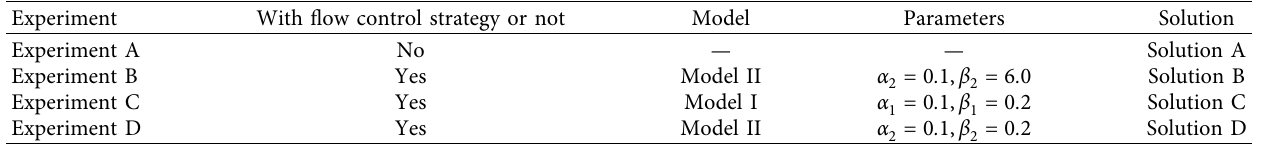
Table 16: Four experiments.